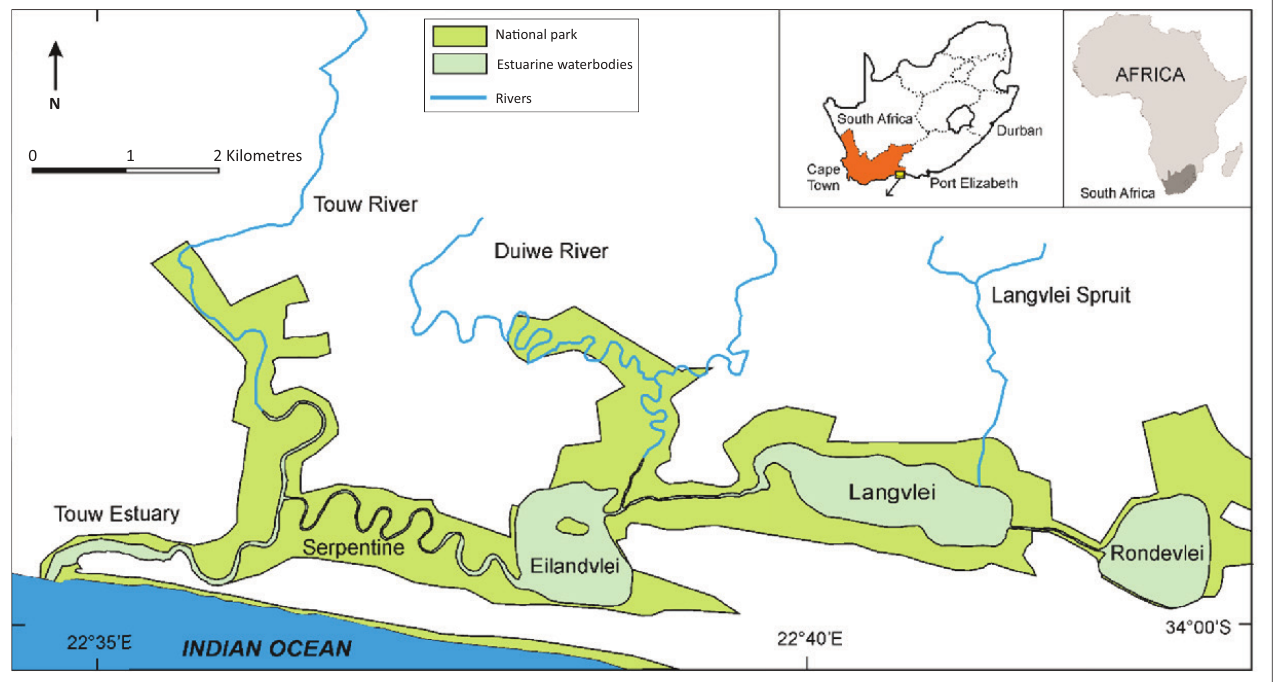
FIGURE 1: Map of study area showing relative position of estuarine lakes within the Wilderness Lakes